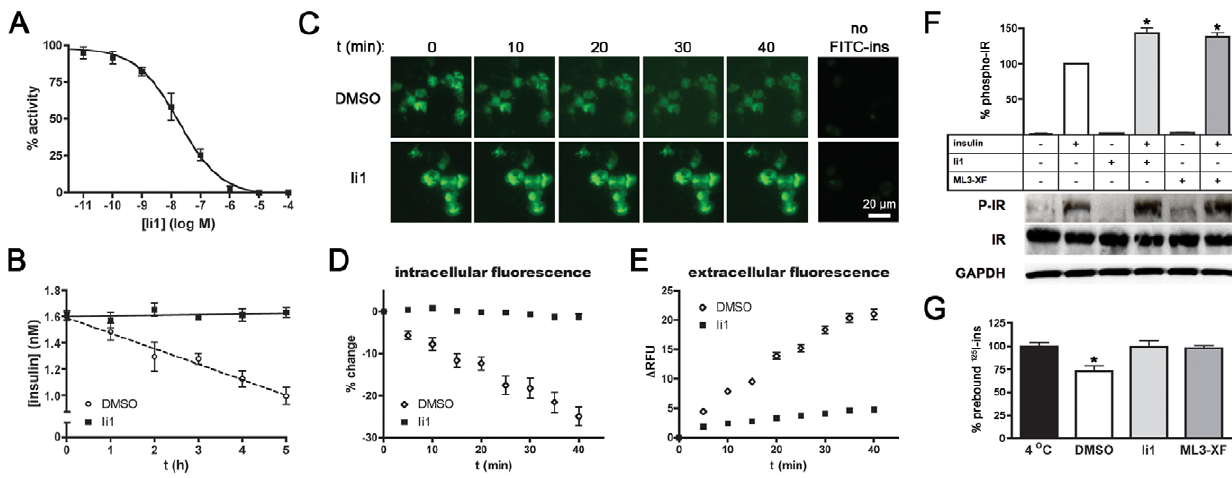
Figure 5. Effects of IDE inhibitors on insulin catabolism and signaling in cells. A , Dose-response curve of Ii1-mediated inhibition of insulin degradation by CHO-IR cells. Note that the potency of Ii1 in this context is comparable to that obtained in vitro ( c.f. , Fig. 3A). B , Progress curve of insulin degradation by CHO-IR cells in the absence or presence of Ii1 (10 m M). Note that insulin catabolism is completely inhibited by Ii1. C–F , Effects of Ii1 on insulin catabolism in live cells. C , Representative images of live CHO-IR cells pre-loaded with FITC-ins and imaged at various time points in the presence or absence of Ii1 (10 m M). D,E , Quantitative analysis of intracellular ( D ) and extracellular ( E ) FITC fluorescence from 5 replicate experiments. Data are mean 6 SEM. Note that these experiments were conducted at 22 u C. F , Effects of Ii1 on insulin signaling in CHO-IR cells cold- loaded with insulin. Graph shows IR autophosphorylation (phospho-IR) determined by ELISA in response to 5-min incubation at 37 u C in the presence of Ii1 (10 m M), ML3-XF (10 m M) or vehicle (DMSO). Data are mean 6 SEM of 6 independent experiments, where data are normalized to IR autophosphorylation obtained for insulin and vehicle alone. * p , 0.01. Western analysis of a representative experiment ( lower panels ) providing biochemical confirmation of the results obtained by ELISA. G , Preloaded insulin is rapidly catabolized by CHO-IR cells and blocked by IDE inhibitors. Graph shows amounts of 125 I present in CHO-IR cells cold-loaded with 125 I-insulin then incubated for 5 min at 37 u C in the presence of IDE inhibitors (10 m M) or vehicle then washed to remove insulin catabolites. Data are mean 6 SEM of 4 experiments expressed as a percentage of 125 I present in control cells maintained at 4 u C.